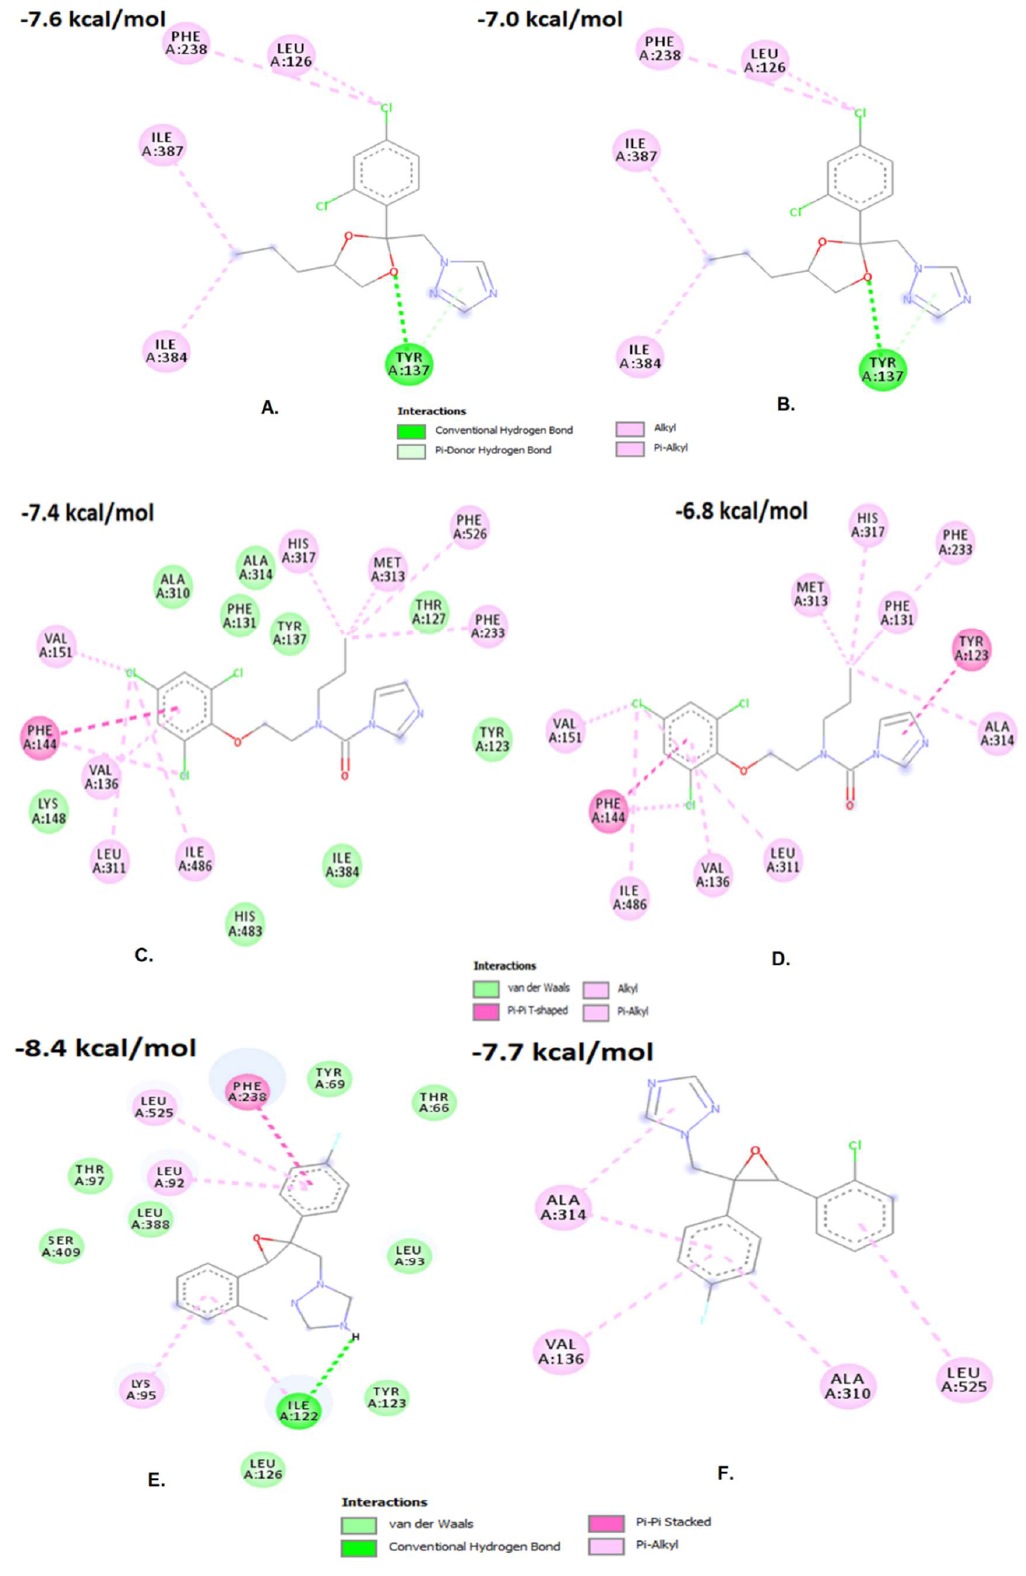
Figure 2. Results for interacting amino acid residues of Cyp51 gene of Cercospora beticola . ( A ). Cyp51 _WT and propiconazole binding, ( B ). Cyp51 _MT and propiconazole binding; ( C ). Cyp51 _WT and prochloraz binding, ( D ). Cyp51 _MT and prochloraz binding; ( E ). Cyp51 _WT and epoxiconazole binding, ( F ). Cyp51 _MT and epoxiconazole binding. The values mentioned in the figures are binding affinity values. “WT” stands for wild type genotype and “MT” stands for mutant type